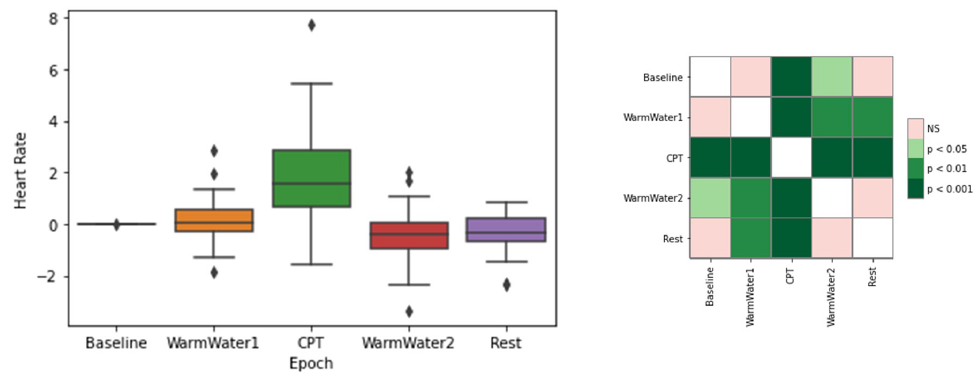
Figure 3. Boxplot of mean HR values for each epoch ( left ) and respective p -values between different epochs, with Bonferroni correction ( right ). The (cid:5) stands for outliers.